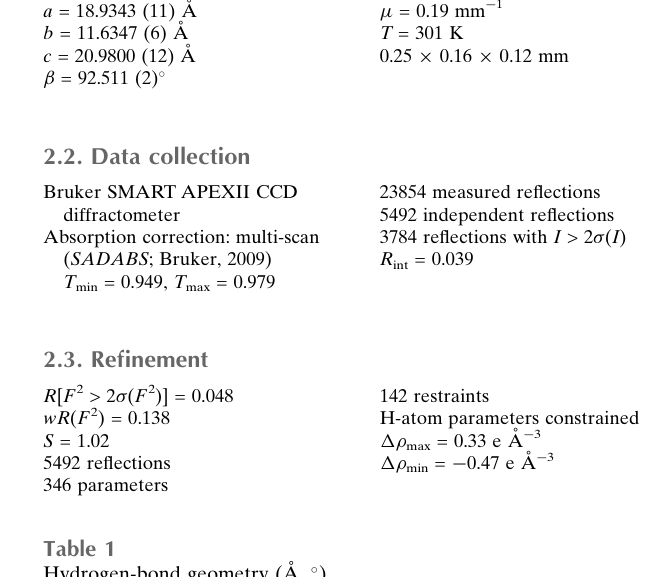
Hydrogen-bond geometry (A˚ , (cid:3)